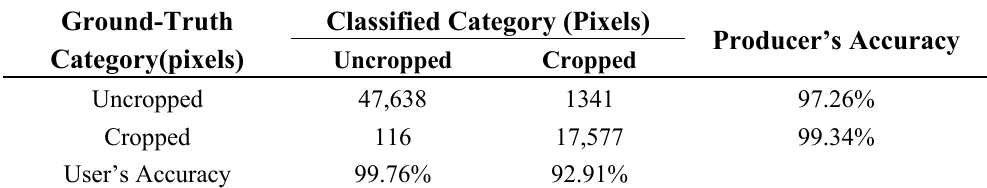
Table 3. Error matrix and accuracy for 2010 cropped/uncropped map.